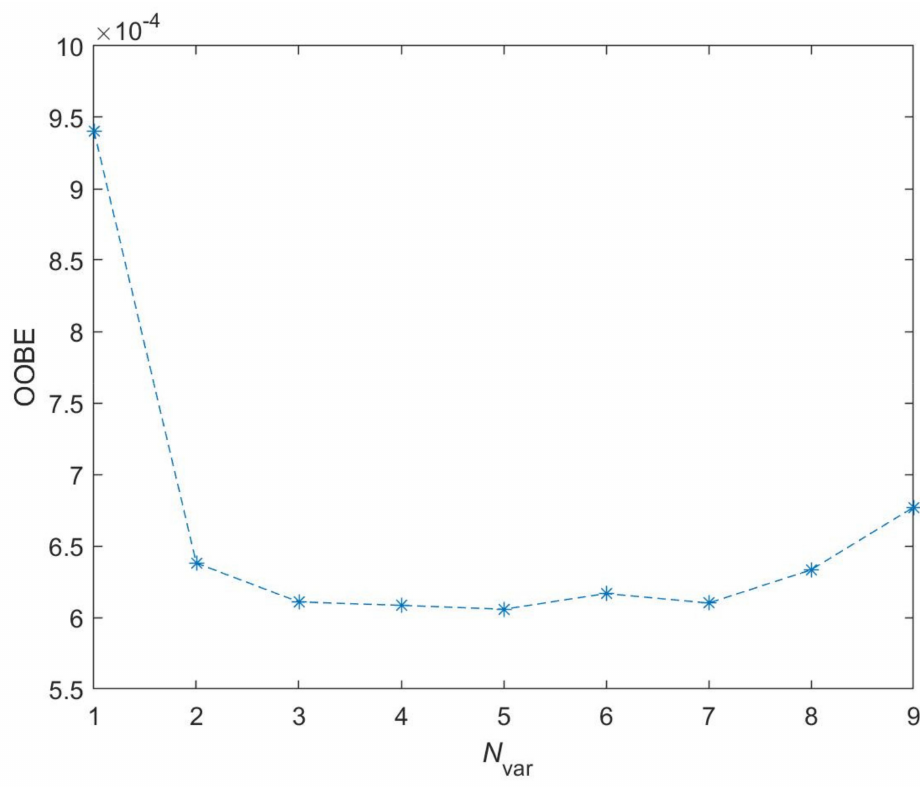
Figure 4. Variation of the OOBE with the N var increasing from 1 to 9.